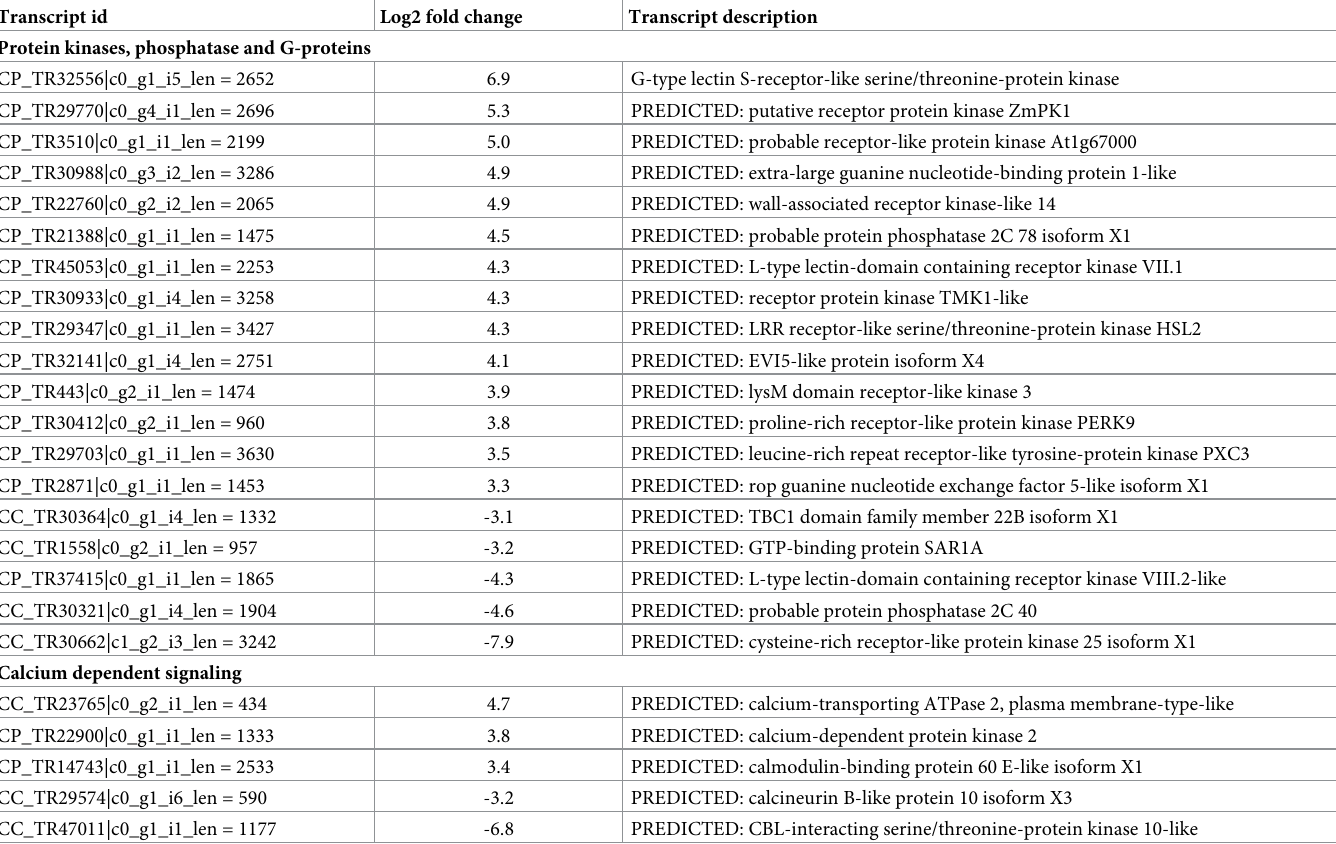
Table 2. Representative transcripts related to signaling differentially expressed in C . platycarpus compared to C . cajan . Transcript id Log2 fold change Transcript description Protein kinases, phosphatase and